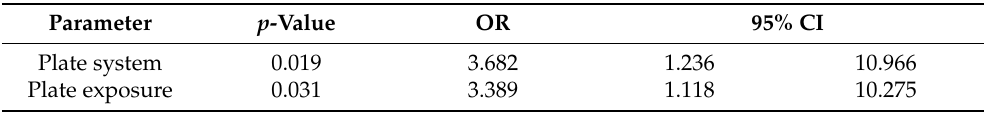
Table 5. Multivariate analysis of significant risk factors on the incomplete osseous union in univariate binary logistic